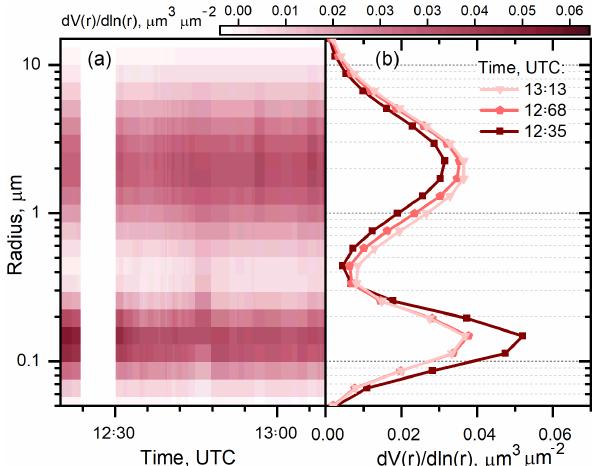
Figure 8. Spatio-temporal variability of total column aerosol vol- ume size distribution retrieved with GRASP-AOD using mobile sun photometer measurements along the Lille–Dunkerque transect on 26 August 2016 (12:18–13:10UTC).